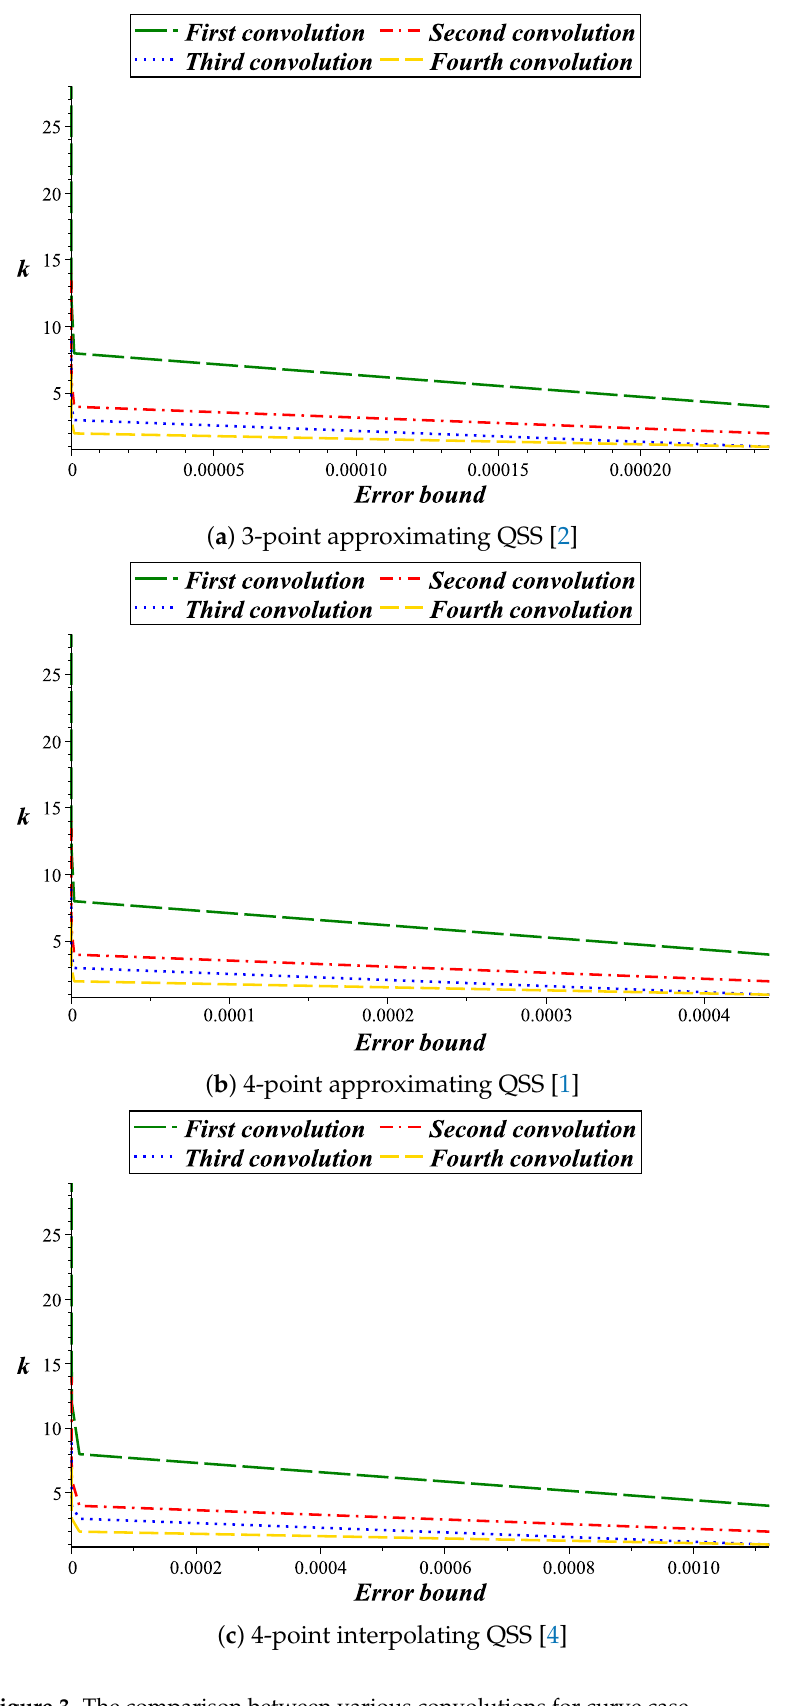
Figure 3. The comparison between various convolutions for curve